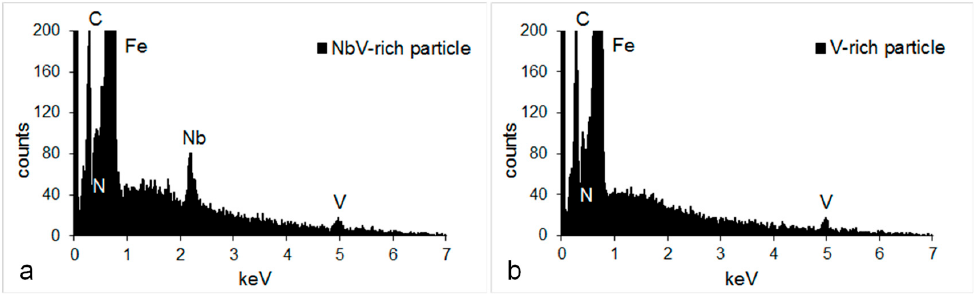
Figure 4. Typical SEM-EDS spectra of >20 nm ( a ) NbV-rich and ( b ) V-rich particles.